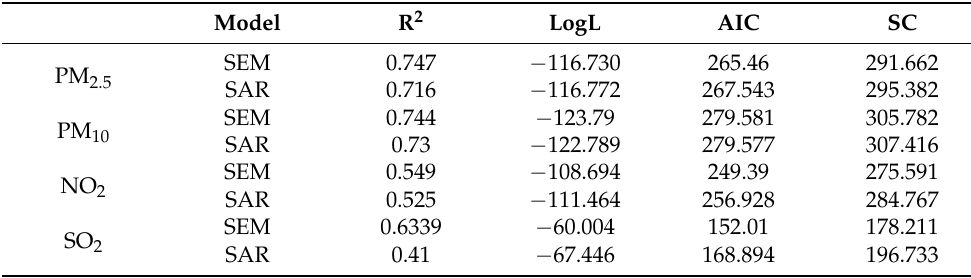
Table 3. Information comparison of SEM and SAR